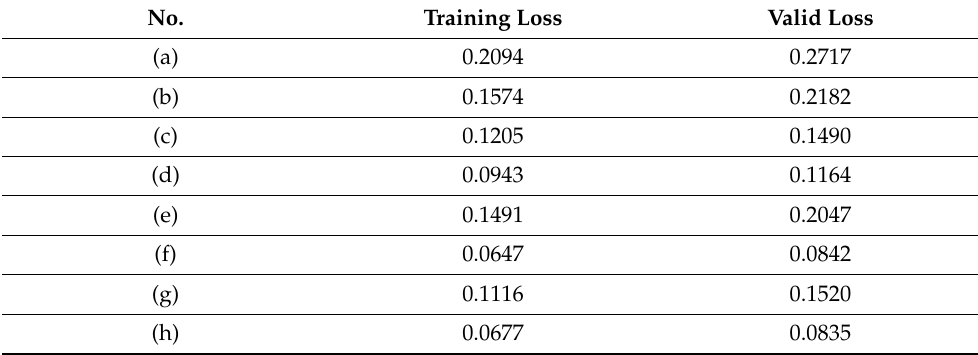
Table 4. Training and valid losses under each scenario.